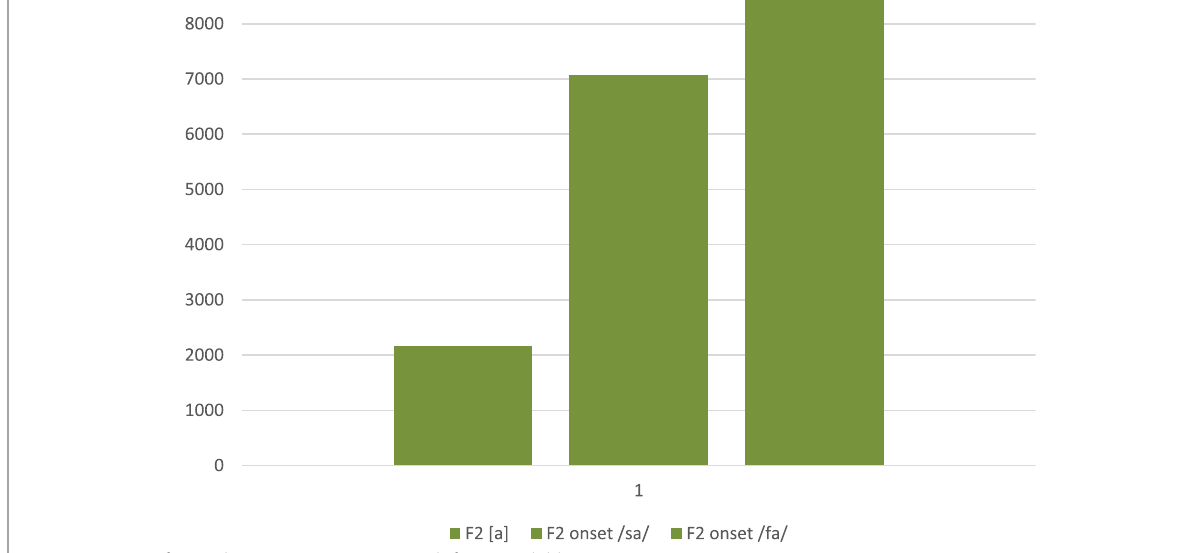
Fig. 2 Mean F2 of [a] and mean F2 onset in /sa/ and /fa/ in TD children